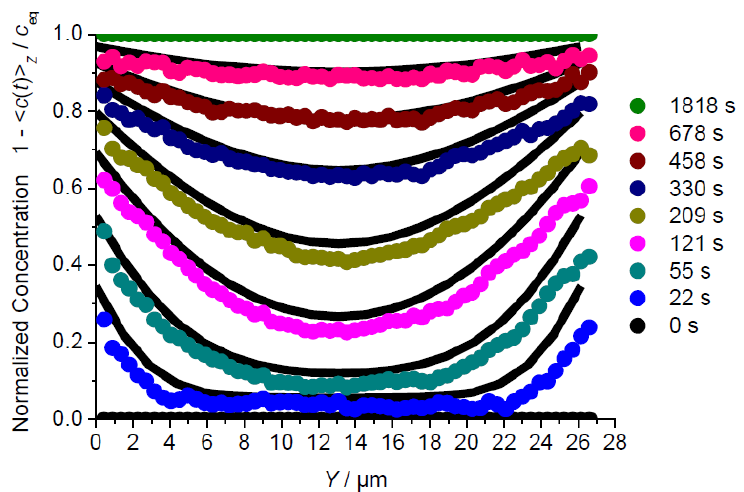
Figure 4. Evolution of the profiles of mean concentration < c ( t )> observation perpendicular to the XY plane along the Y direction (Figure 1b, Scheme 3) during release of methyl-butane by a pressure step from 1 mbar to 0. The experimental values (circles in color) are complemented by the data determined from the solution of Fick’s 2nd law with the diffusivities and permeabilities given in Table 1 (black